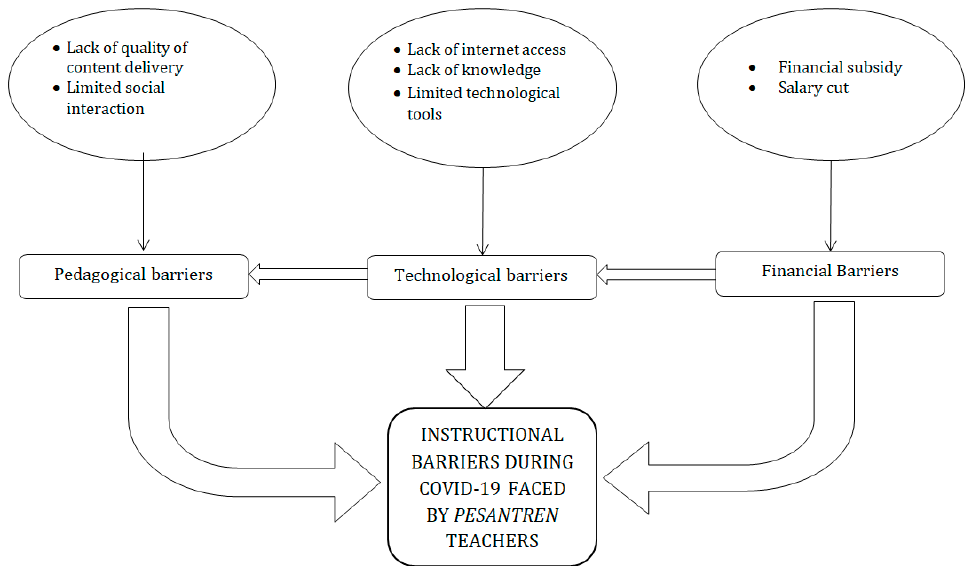
Figure 1. Conceptual map of the study.